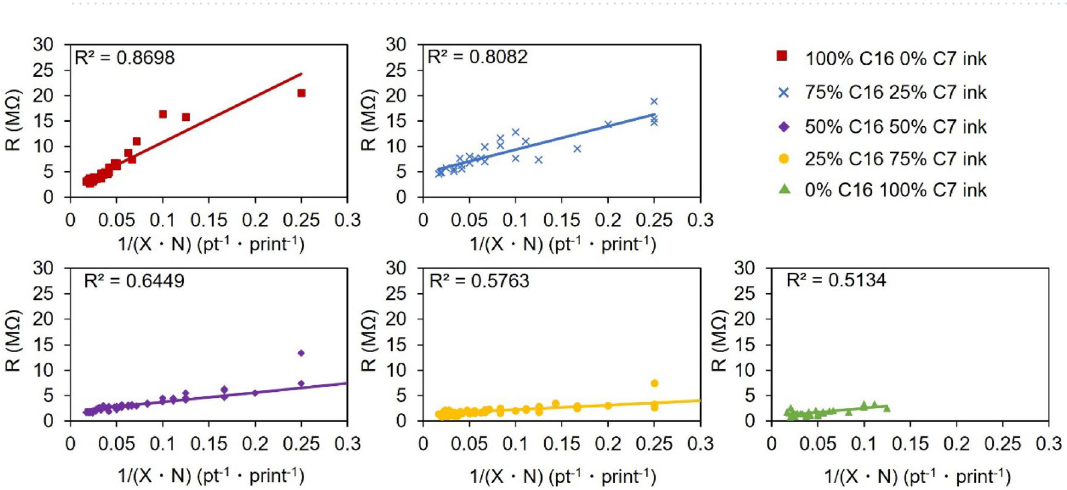
Figure 5. Comparison of the linearity of resistance verses 1/(X•N) plots of inks made with different C7/C16